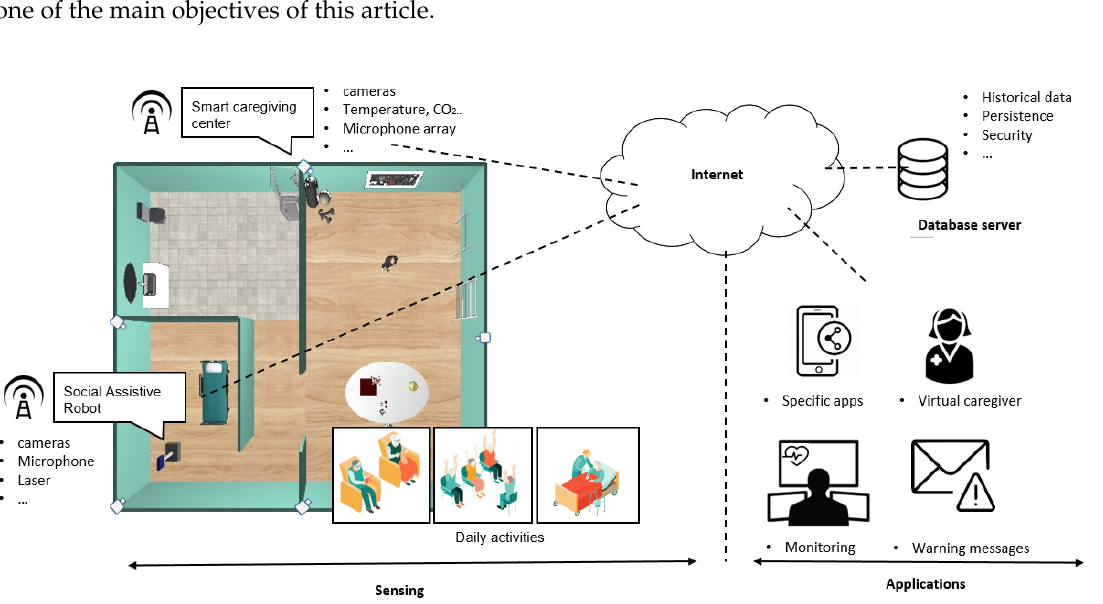
Figure 1. General view of a Cyber-Physical System for caregiving